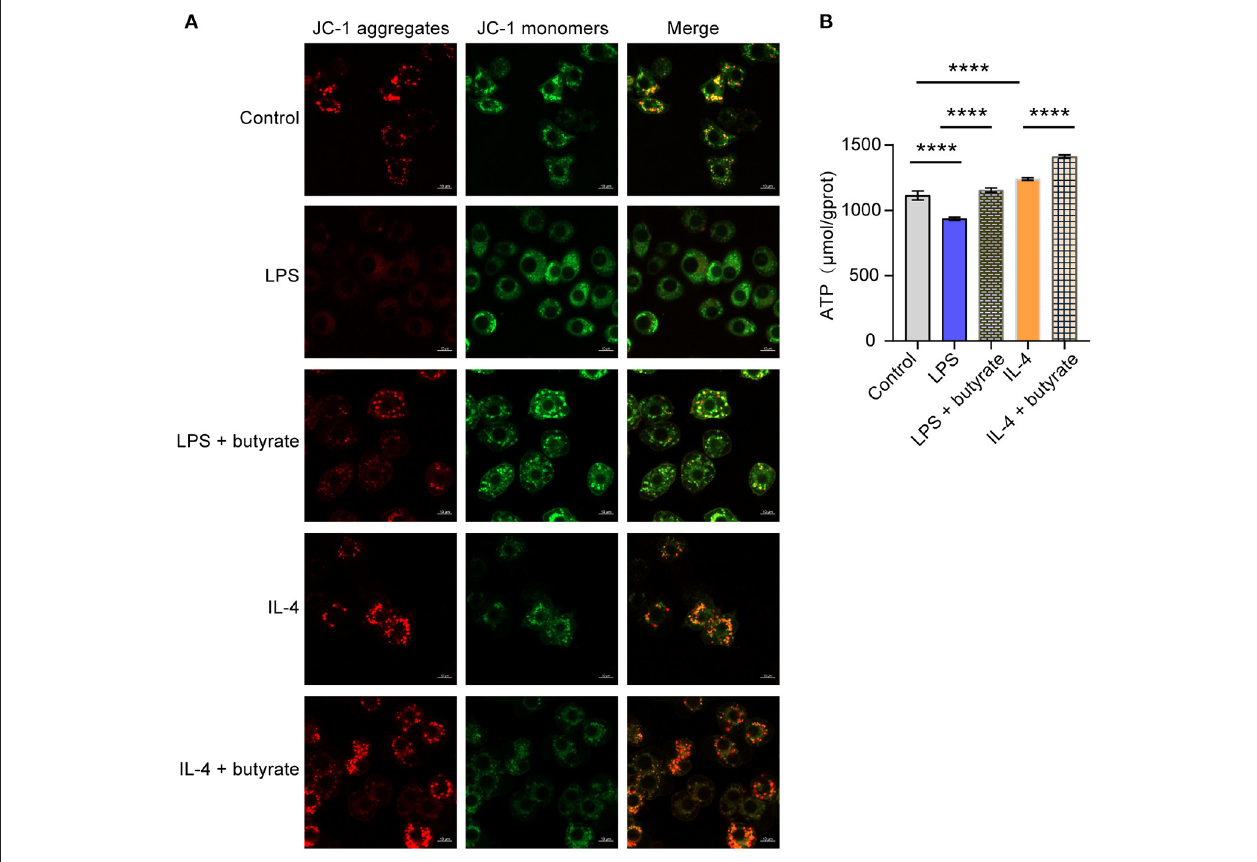
FIGURE 4 | Butyrate regulated M1/M2 polarization of macrophages, thus affecting mitochondrial function. (A) Mitochondrial membrane potential detection. (B) ATP content. **** P <